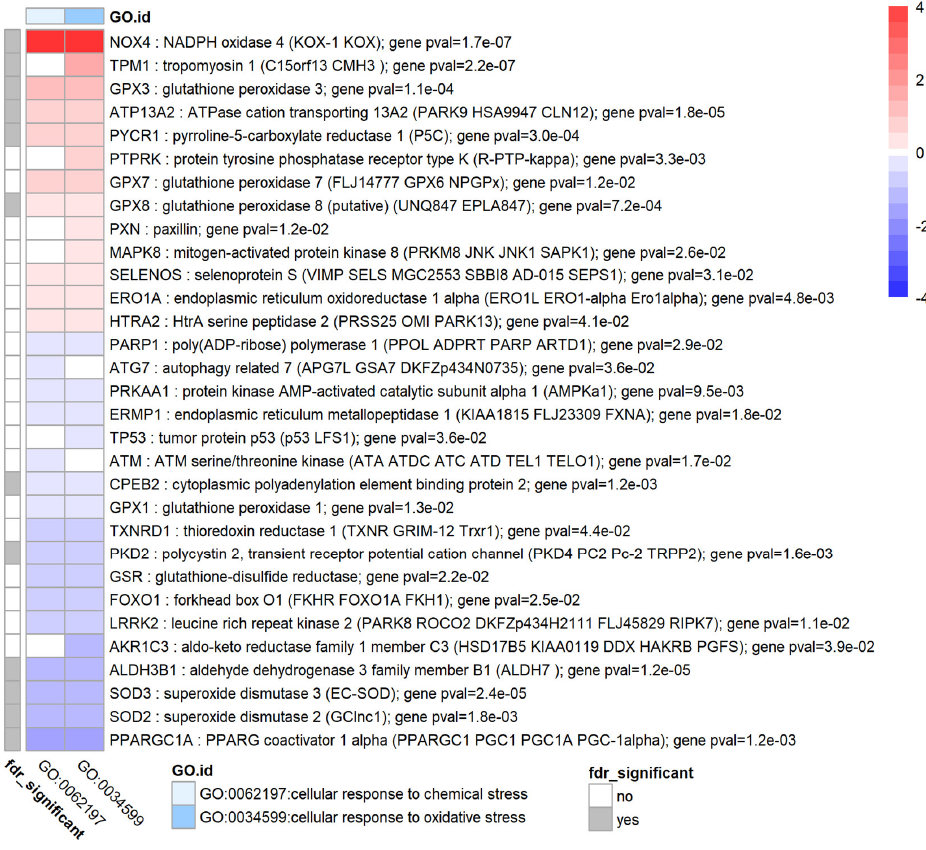
Figure 7. Genes and enrichment terms associated with the cluster ‘oxidative stress’. Heatmap showing the genes with false discovery rate FDR < 0.05 for genes associated with enrichment terms related to oxidative stress. Heatmap colours correspond to fold change expressed as log 2 FC which has been limited to a range of [ − 4, 4] for clarity. The grey annotation bar on the left shows if the genome-wide false discovery rate has an FDR < 0.05 (in which FDR is the BH corrected p -value) for a particular